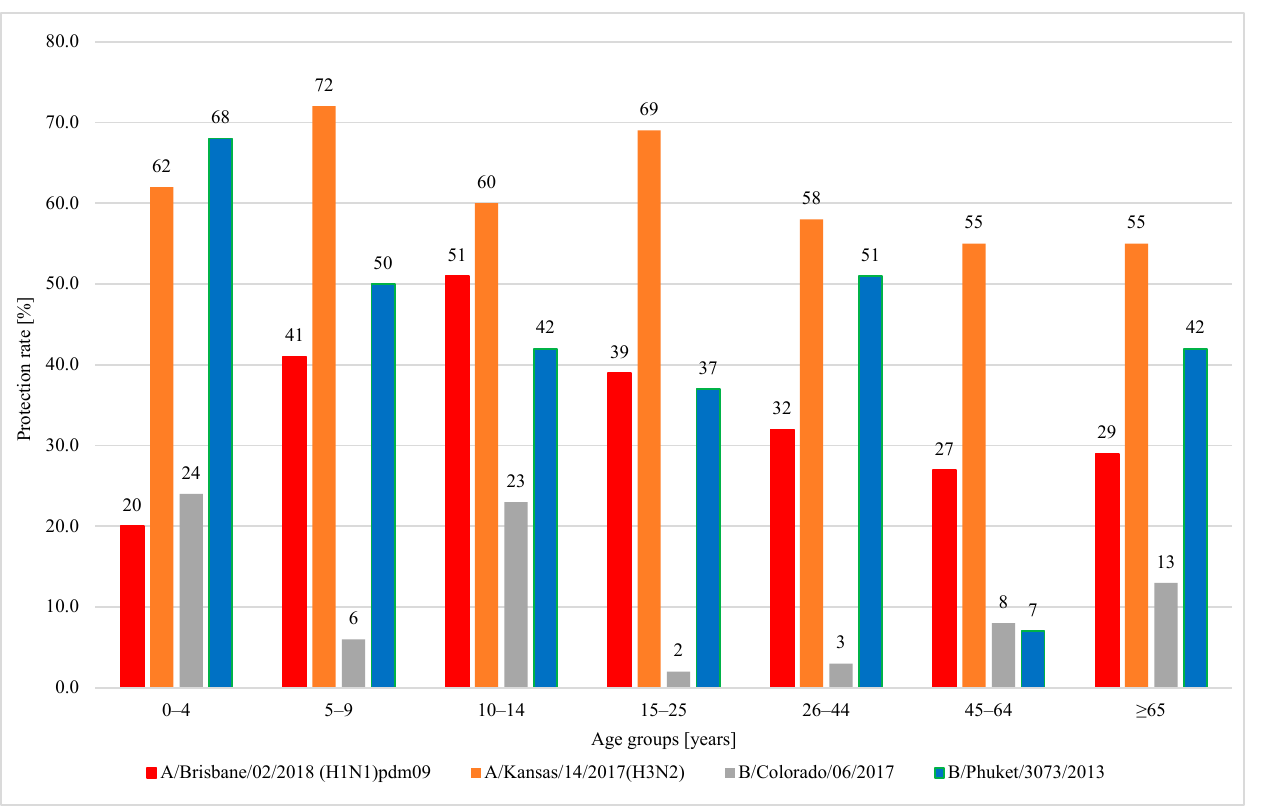
Table 1. Comparison of three epidemic seasons for B/Phuket/3073/2013—Yamagata Lineage. Protection Rate The Significance of Age Group [Years]